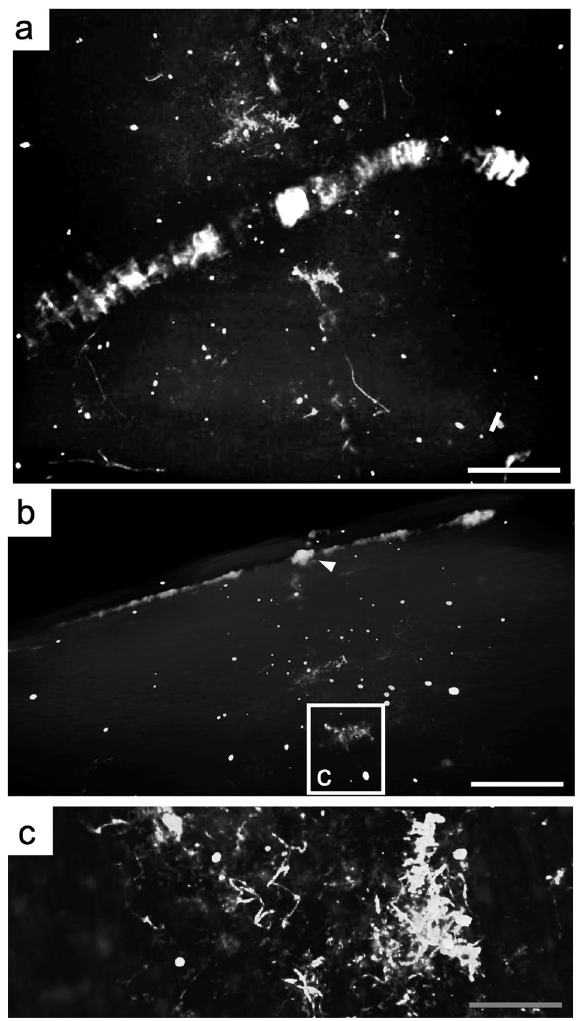
Figure 5. Exploratory µCT volume analysis. ( a ) µCT image of the top bedding surface of HCS-72 with high- density, ribbon-shaped material throughout the bedding planes. ( b ) µCT image of side view of HCS-72 (arrow) above unexposed, internal material. ( c ) µCT image of high-density material in ( b ) (rectangle). White scale bar = 1 mm, grey scale bar = 0.5